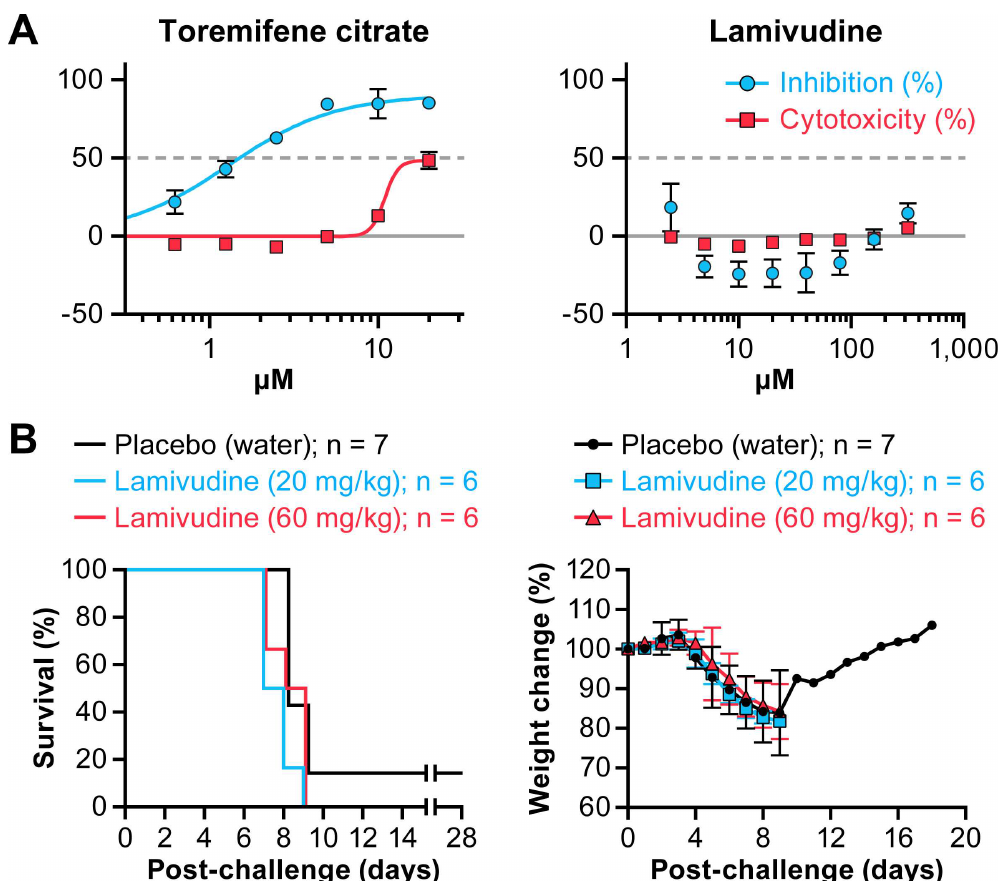
0.1 for 48 h. Antiviral activity is shown in blue and cytotoxicity is shown in red. The experiment was run on duplicate plates with triplicate wells per dose (mean ± SD; n = 3). Representative graphs from 2 independent experiments are shown. (B) Percent survival and weight loss of lamivudine-treated guineapigs infected with guineapig-adapted- Ebola virus/Mayinga variant (GPA-EBOV/May). Two groups of guineapigs (n = 6) received oral lamivudine at 20